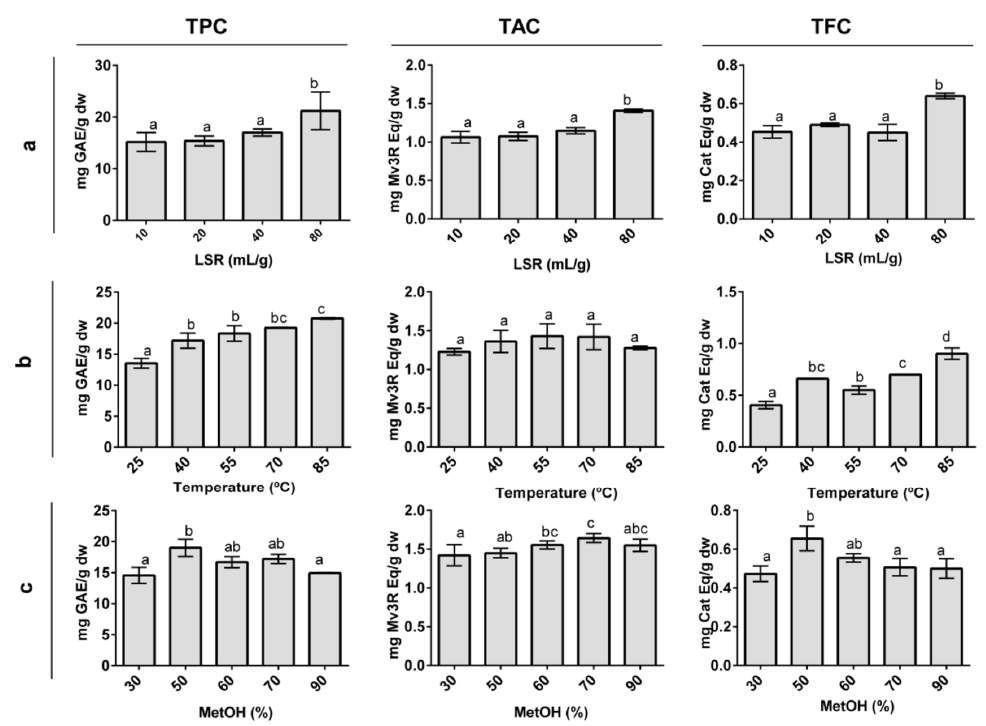
Figure 1. Effect of different liquid-to-solid ratios ( a ), temperatures ( b ), and methanol proportions ( c ) on total phenolic (TPC), total anthocyanin (TAC), and total flavanol (TFC) content in organic whole red Grenache grapes. The results are expressed as mg of phenolic equivalents per gram of dry weight (mg Eq/g dw) ± SD (n = 3). Letters represent significant differences (One-way ANOVA; p < 0.05). Abbreviations: liquid-to-solid ratio (LSR), methanol (MetOH), gallic acid equivalents (GAE), malvidin-3- O -rutinoside (Mv3R), and catechin